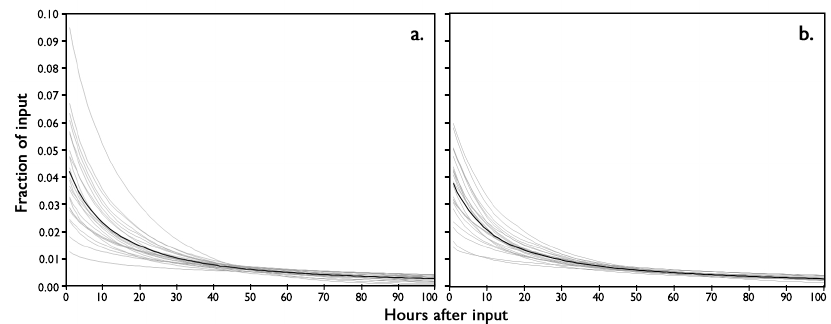
Figure 8. Hydrologic response curves for the 23 storm events in the ( a ) mined and ( b ) forested catchments. Response curves for individual events are shown in gray; black line shows the average of response curves for each catchment.